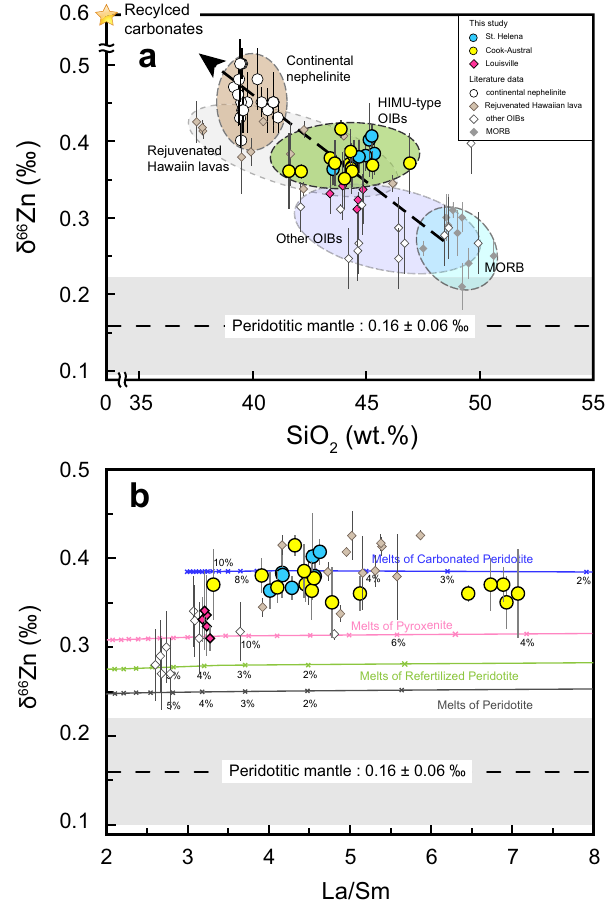
Fig. 2 | Variations in δ 66 Zn versus SiO 2 (a) and La/Sm (b) for HIMU basalts. All samples in a have high MgO contents (MgO>8wt.%).Therefore, all samples shown in a are less-evolvedsamplesand are suitablefordiscussion aboutthe natureof its mantlesource.ClassicHIMUOIBsareshownbyyellow(Cook-Australsamples)and bluecircles(St.Heleneasamples).Zincisotopesandothergeochemicaldata(major and trace elements) of HIMU basalts can be found in Supplementary information, Note1,SupplementaryTable1.1andSupplementaryTable7.Estimated δ 66 Znvalues of the peridotitic mantle are taken from ref. 27. δ 66 Zn values of samples from continental nephelinite, MORB and other OIBs are also shown (Data are from refs. 21 – 23, 29 – 31). The black arrow in a points to the direction of increasing contribu- tion of recycled carbonates. Error bars on δ 66 Zn represent 2 standard deviations (2SD) uncertainties. The gray line in b represents model calculations for melts of peridotite. The green line represents model calculations for melts of refertilized peridotite.Silicicmeltsreleasedfromrecycledoceaniccrustmetasomatizenormal peridotite and therefore produce such refertilized peridotite, as mentioned in Herzberg et al. 41 . The pink and blue lines represent model calculations for melts of pyroxenite and carbonated peridotite, respectively. Inset numbers indicate the degreesofpartialmelting.SeeSupplementaryinformation,Note4formoredetails about model calculations of mantle partial melting. MORB=Mid-Ocean Ridge Basalt; OIB=Ocean Island Basalt; HIMU=high μ ( μ = 238 U/ 204